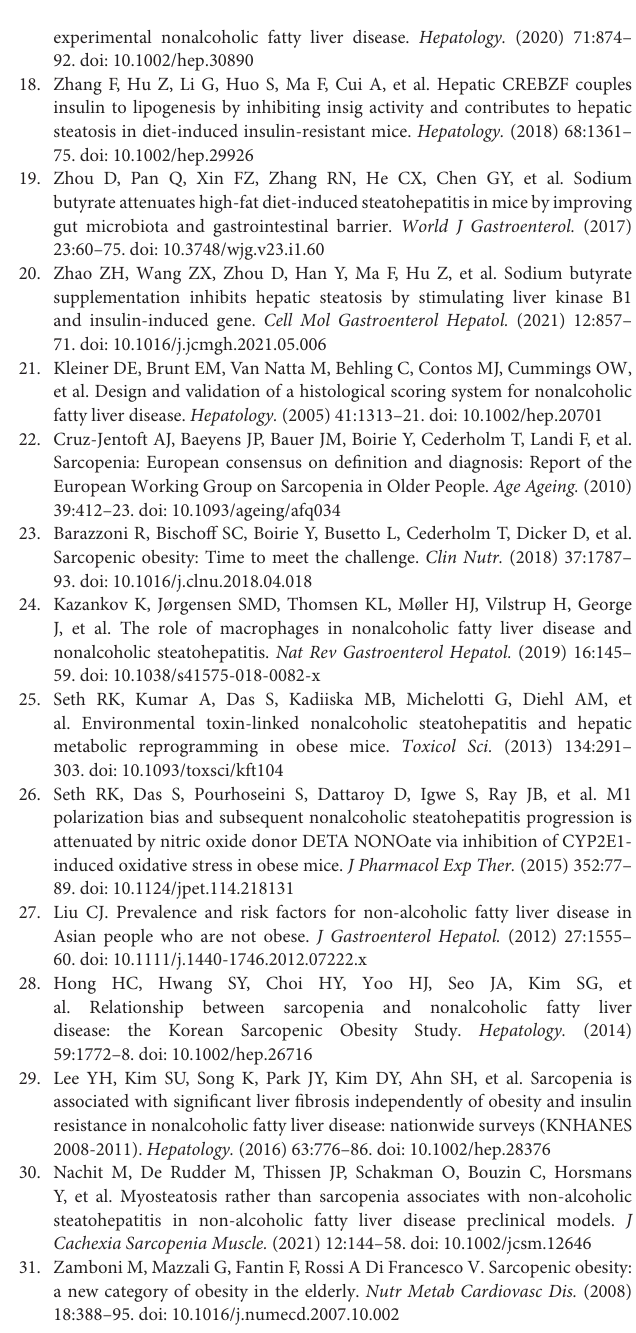
Supplementary Figure 3 | The correlation analysis of plasma ammonia and other indexes in middle-aged mice at week 20. (A) Correlation between plasma ammonia level and other indexes in middle-aged mice including body weight, liver index, NAS score, fat mass, fat mass/BW, lean mass/BW, grip strength, and muscle fiber diameter (Spearman correlation analysis, n = 10–11). The data are presented as the mean ± SEM. Supplementary Figure 4 | Detailed NAFLD activity score and hepatic gene expression analysis in mice treated with LOLA. (A) Steatosis score, (B)